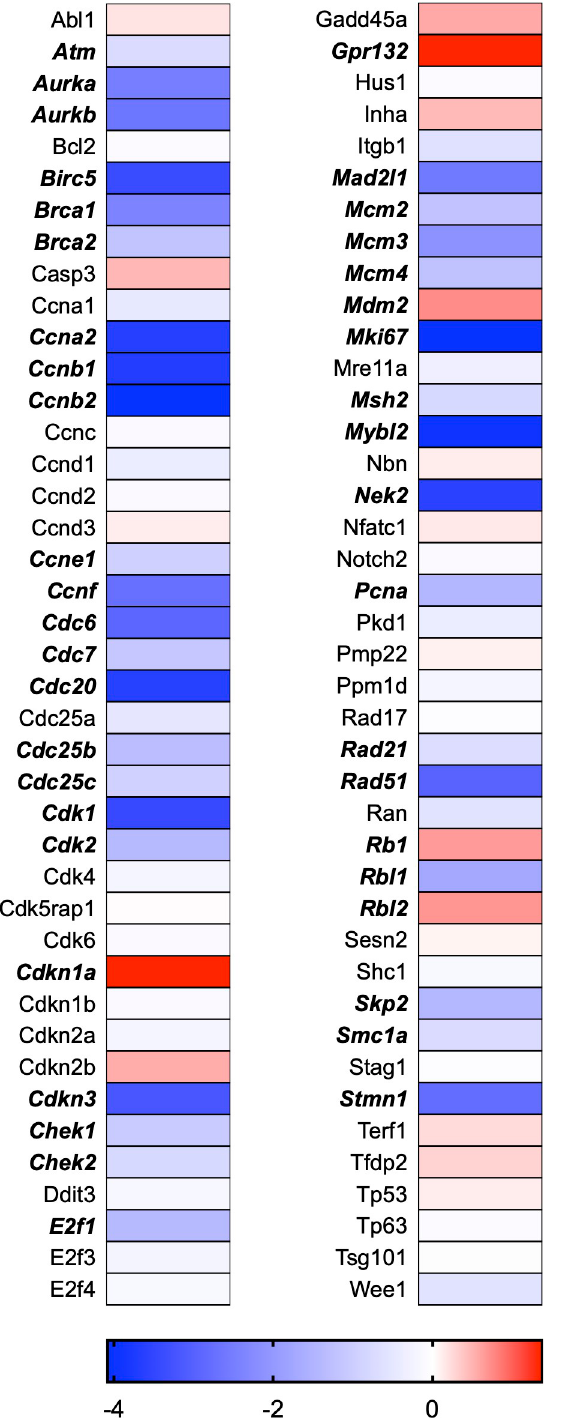
Fig 2. Cell cycle heat map. Bold text indicates significantly altered gene